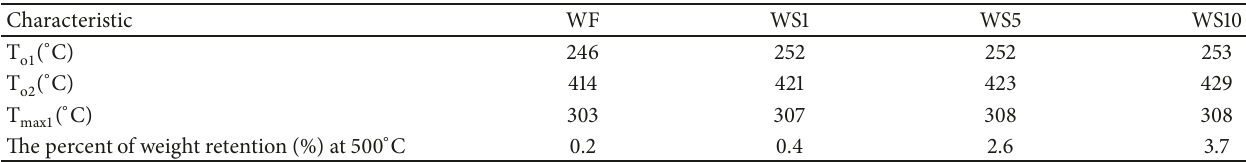
Table 2: TG characteristic of WF and WS